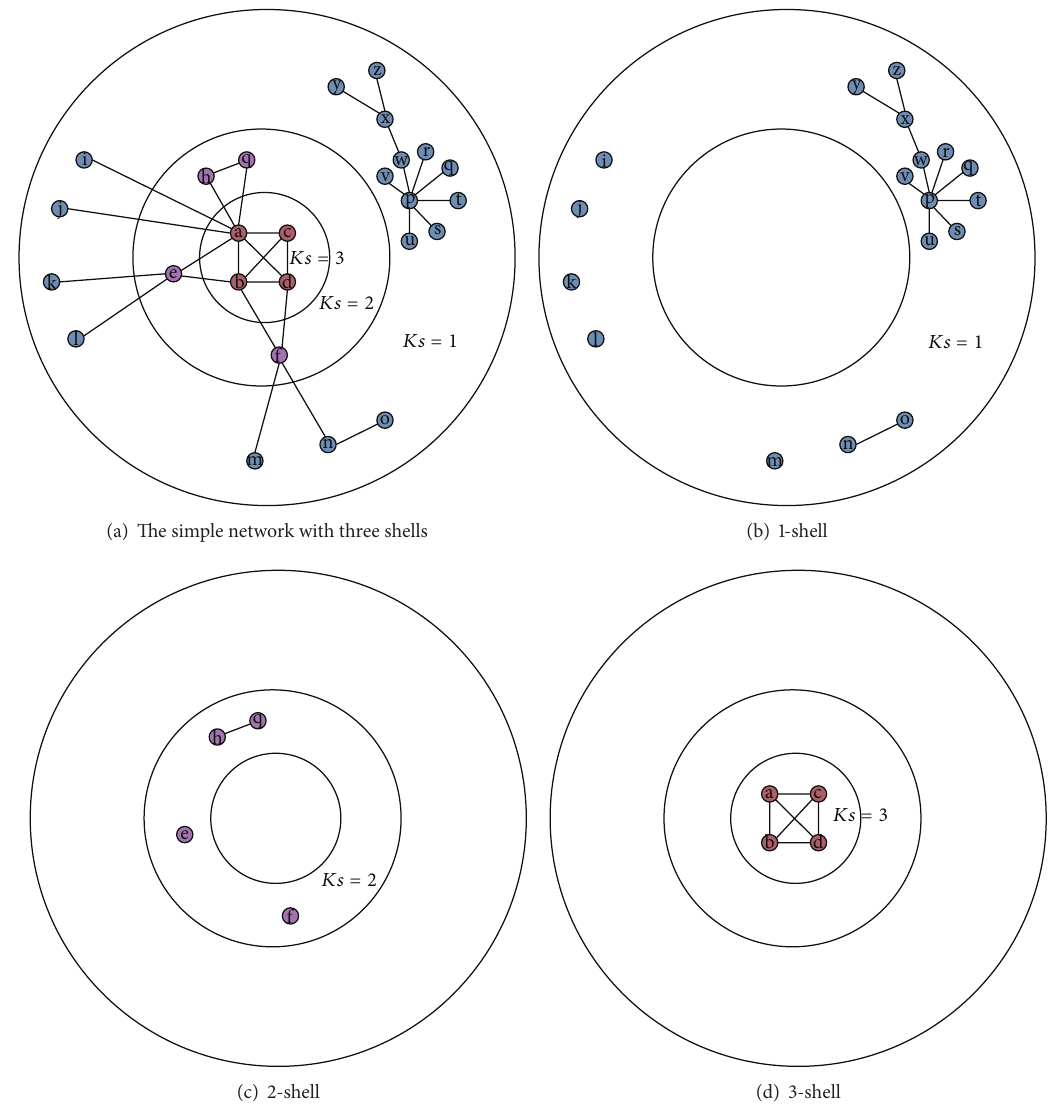
Figure 2: The illustration of 𝑘 -shell decomposition